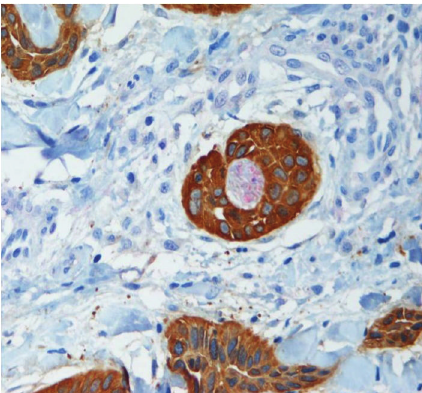
Figure 3: Perineural invasion. A small nerve branch (red) com- pletely surrounded by squamous cell carcinoma (brown) in a case in which perineural invasion was not detected on H&E. IHC with dual staining for S-100 and AE1/3, original magnification × 200. H&E: hematoxylin and eosin; IHC: